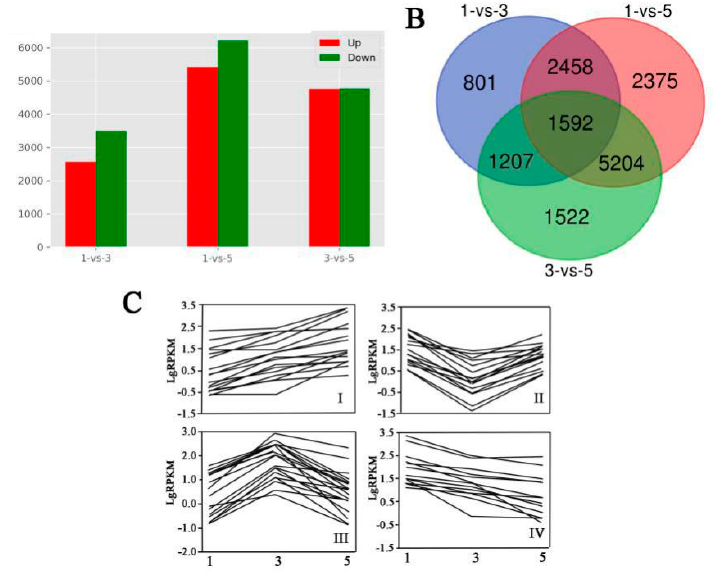
Figure 4. Analysis of mapped transcripts between two libraries. ( A ) Comparison of upregulated and downregulated differentially expressed genes (DEGs) in three sets. ( B ) Venn diagram representing the numbers of DEGs and the overlaps of sets obtained across three comparisons. ( C ) Changes in gene expression profile among the different segments.